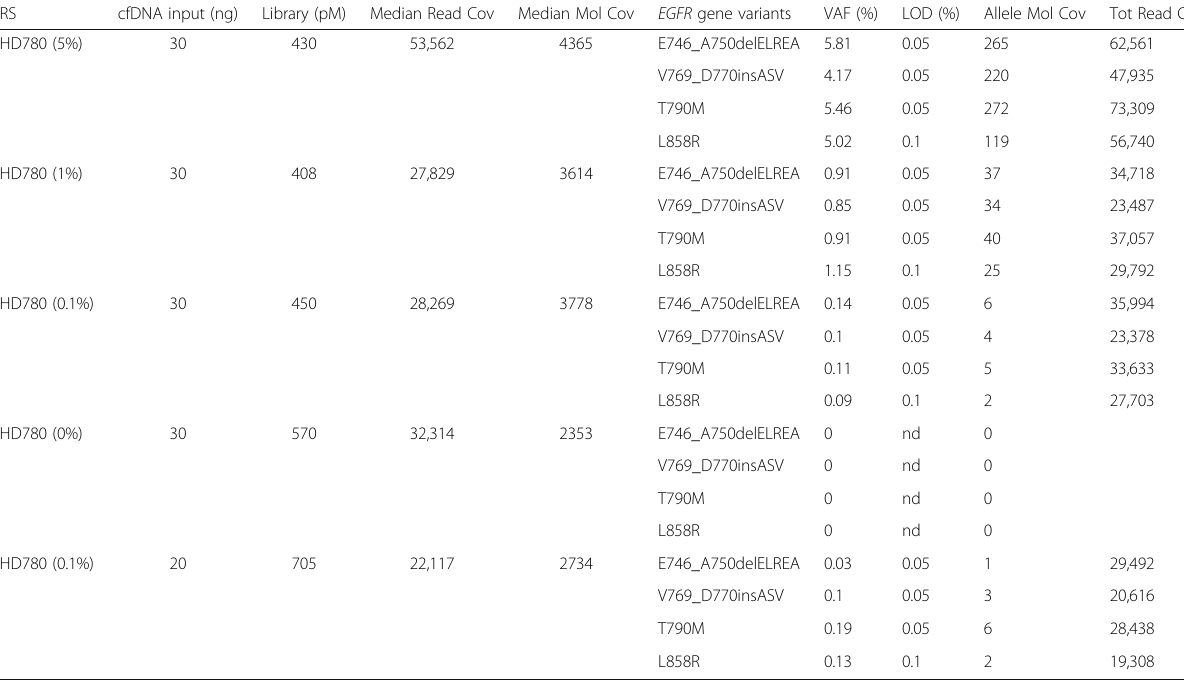
Table 1 Analytical testing of tag-based NGS